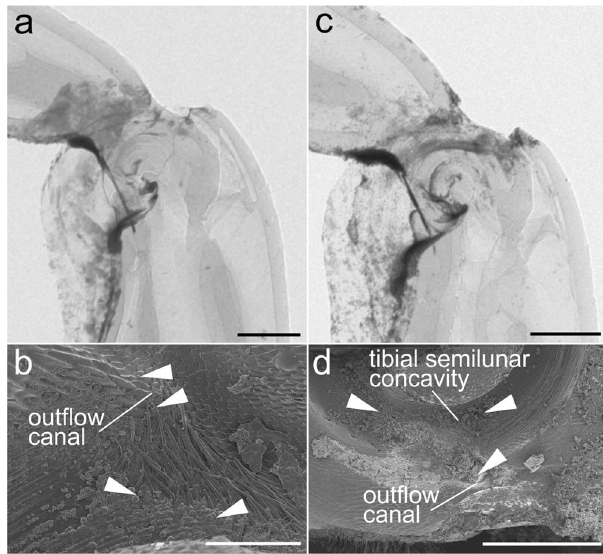
Fig. 4 Experimental results for contamination of internal cavity of the joint based on micro-CT and SEM data. a Femoro-tibial joint with metallic particles (1 – 3 µ m) after 1500 opening and closing cycles, lateral view, micro-CT image; b the same joint sample, sagittal section, SEM micrograph, white arrowheads indicate the particles in the out fl ow canal and tibial semilunar concavity; c femoro-tibial joint with metallic particles (2 – 5 µ m) after 1500 cycles, lateral view, micro-CT image; d the same joint sample, sagittal section, SEM micrograph, white arrowheads indicate the particles in the out fl ow canal and tibial semilunar concavity. Scale bars: a , c 300 µ m, b 50 µ m, d 200 µ